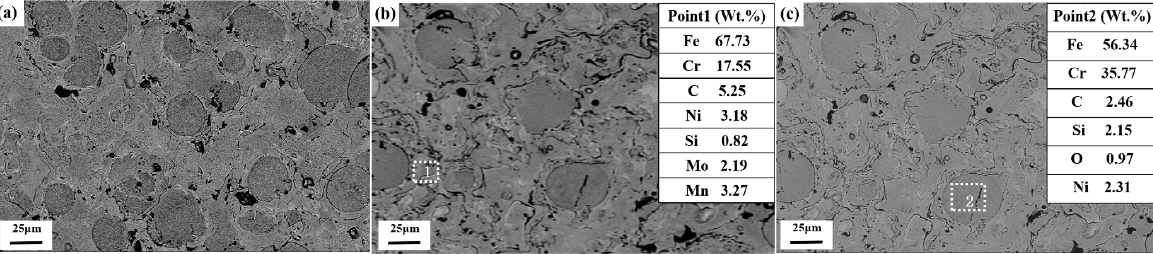
Figure 5. Surface SEM morphologies of the coatings: ( a ) Fe-based coating, ( b ) 6% γ -Fe coating, ( c ) 9% γ -Fe coating.